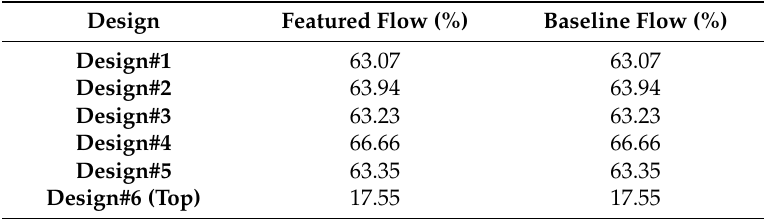
Table 6. Before route and after route cell density in featured flow and in baseline flow.